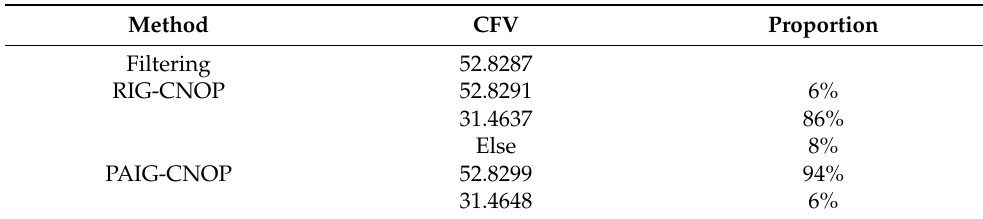
Figure 3. The distribution of the MCFVs corresponding to the CNOPS generated by the different methods at point O , T = 150. Table 2. Statistical analysis of the MCFVs corresponding to the CNOPS generated by the different methods at point O , T =